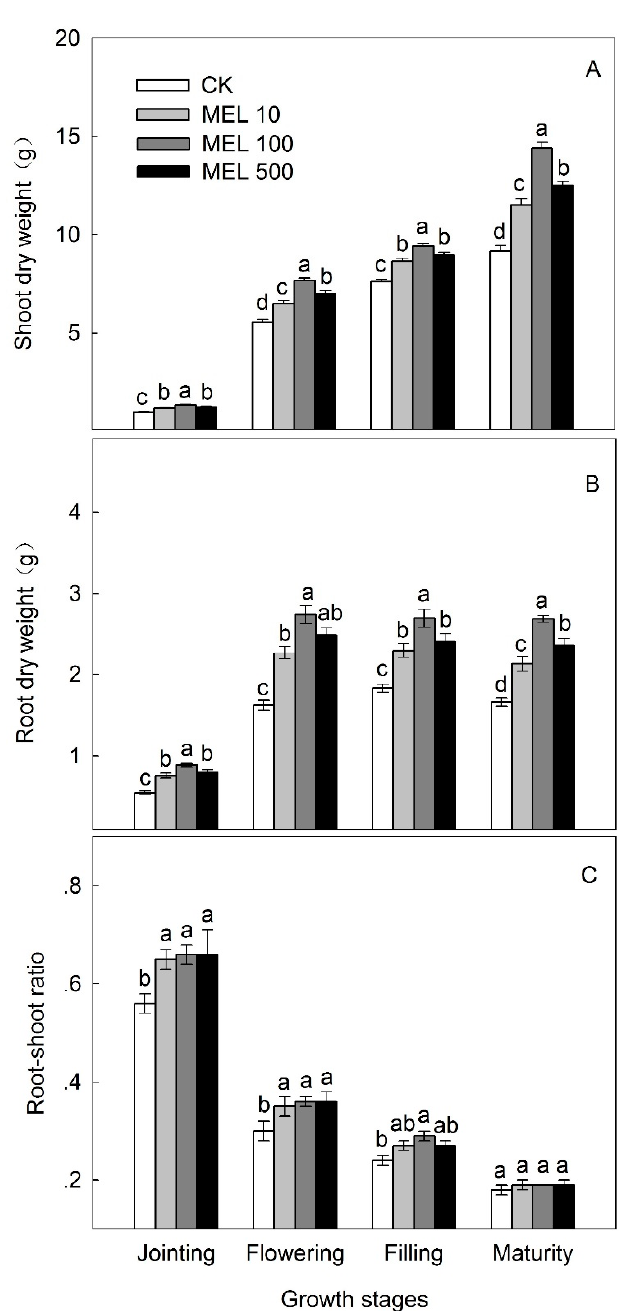
Figure 2. The effects of MEL application on shoot dry weight ( A ), root dry weight ( B ) and root/shoot ratio ( C ) at different growth stages (jointing, flowering, grain filling and maturity stages). Four MEL concentrations were applied: 0 μ M (CK), 10 μ M (MEL 10), 100 μ M (MEL 100) and 500 μ M (MEL 500). Values are means ± SEs of twelve replicates. Significant differences between different treatments are indicated by different letters ( p < 0.05).